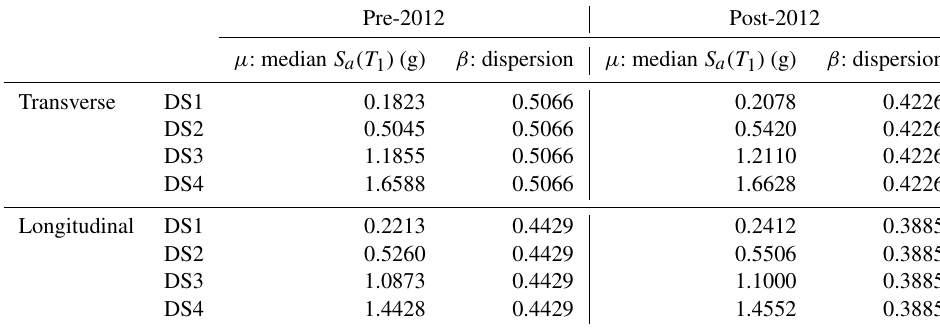
Table 8. Fragility curves of the archetype frames based on cloud analysis ( T 1 = 0 .